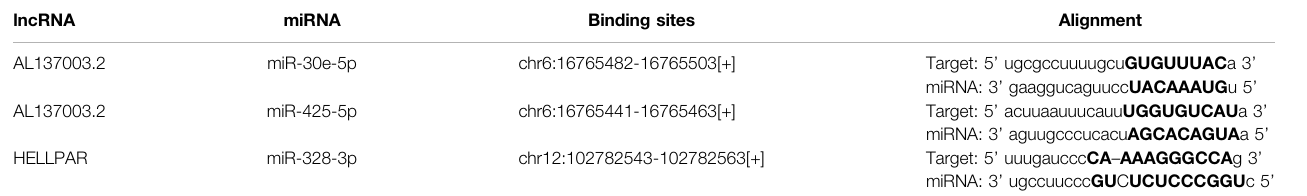
TABLE 3 | The predicted miRNAs which may target to the